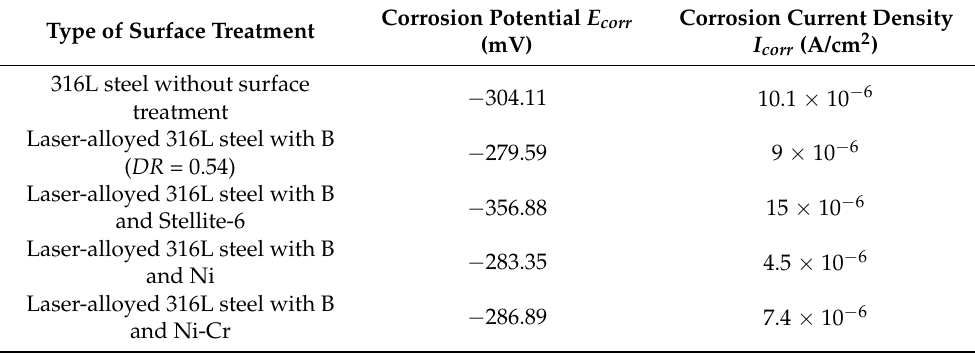
Table 7. Corrosion potential E corr and corrosion current density I corr of laser-alloyed layers, produced in 316L austenitic steel, compared to the same material without surface treatment based on the polarization curves in 1 M H 2 SO 4